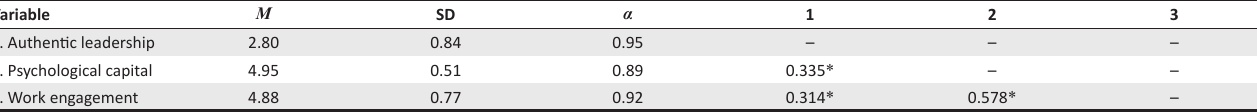
TABLE 1: Descriptive statistics and correlations between the variables ( N = 647). Variable M SD